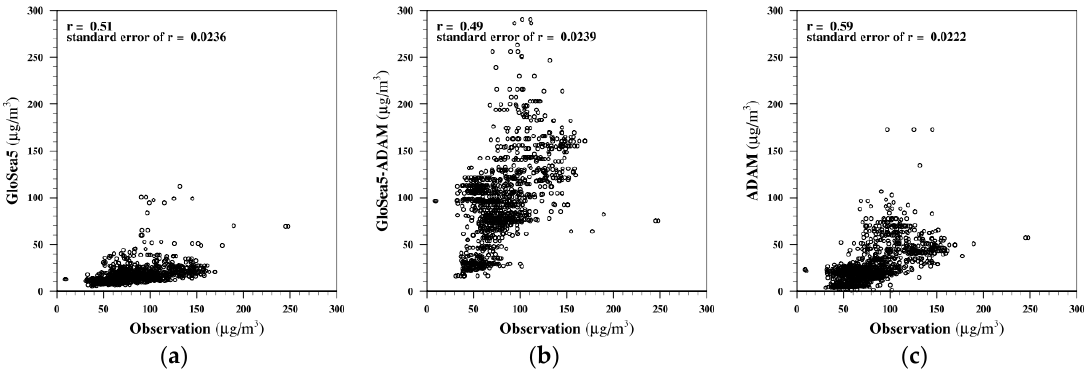
Figure 6. The scatter plots of ( a ) GloSea5 versus Observation, ( b ) GloSea5-ADAM versus Observation, and ( c ) ADAM versus Observation (from March 1 to May 31, 2017).